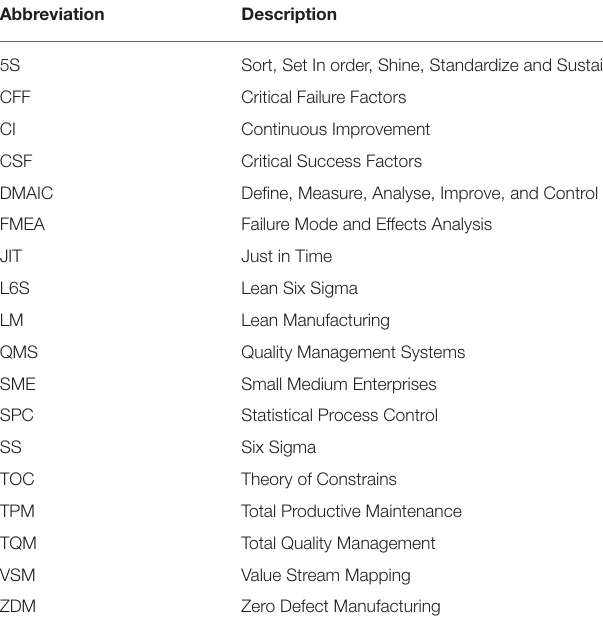
TABLE 1 | Abbreviation